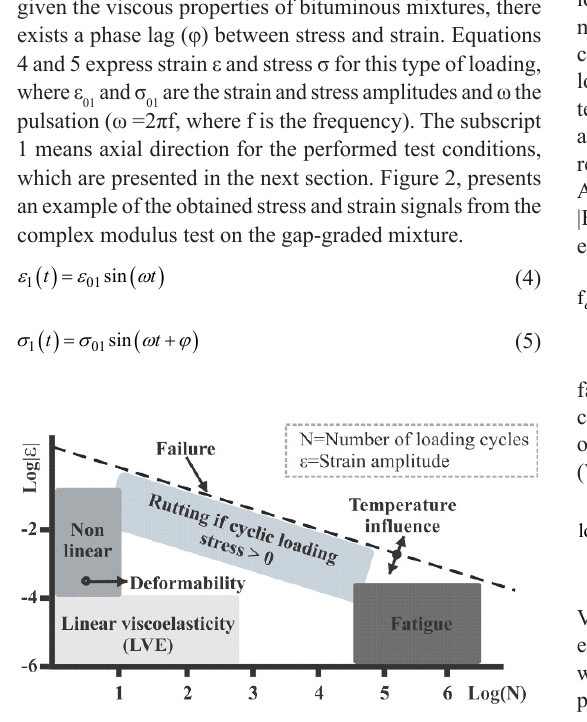
Figure 1. Domains of behaviour for bituminous mixtures 10 .